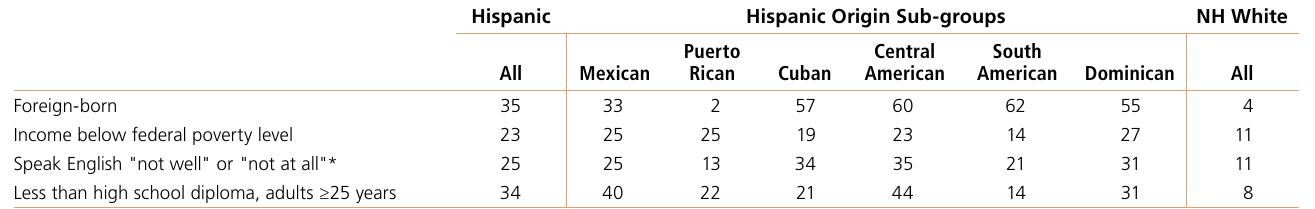
Table 9. Socioeconomic Characteristics (%) by Race/Ethnicity and Hispanic Origin, US,